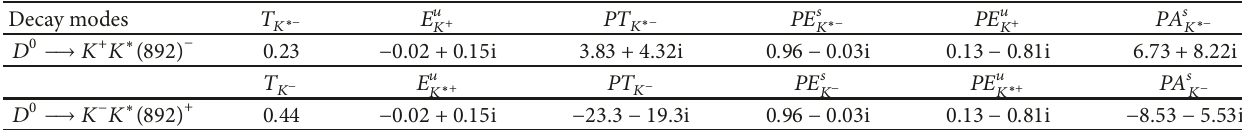
Table 2: Branching ratios (in unit of 10 −3 ) of singly-Cabibbo-suppressed decays 𝐷 0 󳨀→ 𝐾 + 𝐾 ∗ (892) − and 𝐷 0 󳨀→ 𝐾 − 𝐾 ∗ (892) + . Both experimental data [55–57] and theoretical predictions of FAT approach of the branching ratios are listed. Form factors Br( 𝐷 0 󳨀→ 𝐾 + 𝐾 ∗ (892) − ) Br( 𝐷 0 󳨀→ 𝐾 − 𝐾 ∗ (892) + ) Pole 1.57 ± 0.04 3.73 ± 0.17 Dipole 1.69 ± 0.04 4.02 ± 0.19 CLF 1.45 ± 0.04 4.44 ± 0.20 Exp. 1.56 ± 0.12 4.38 ±